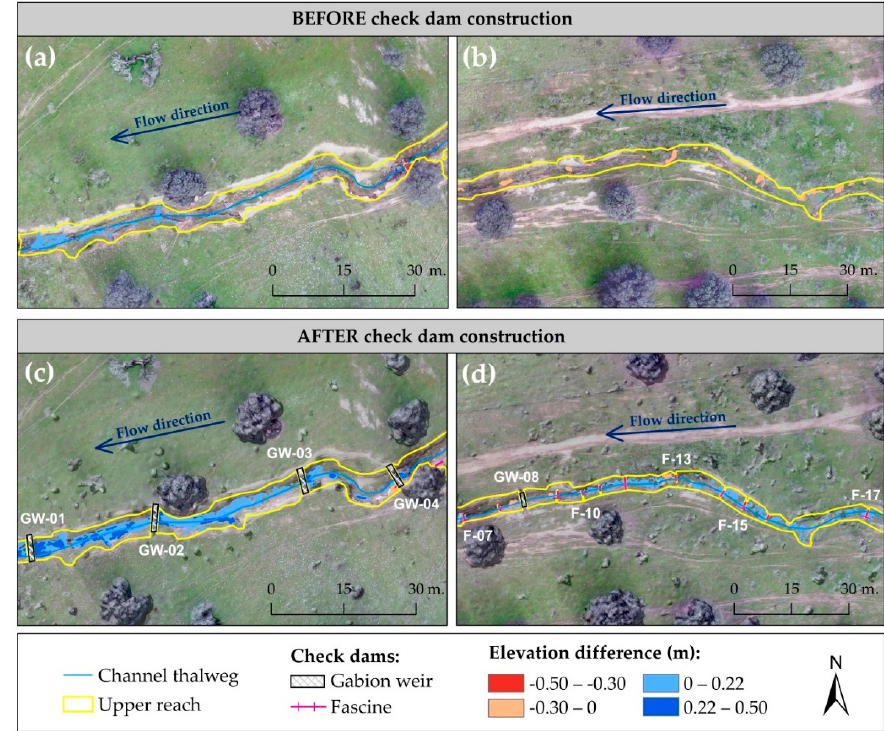
Figure 8. Resulting digital elevation models of differences (DoD) for two reaches at the upper